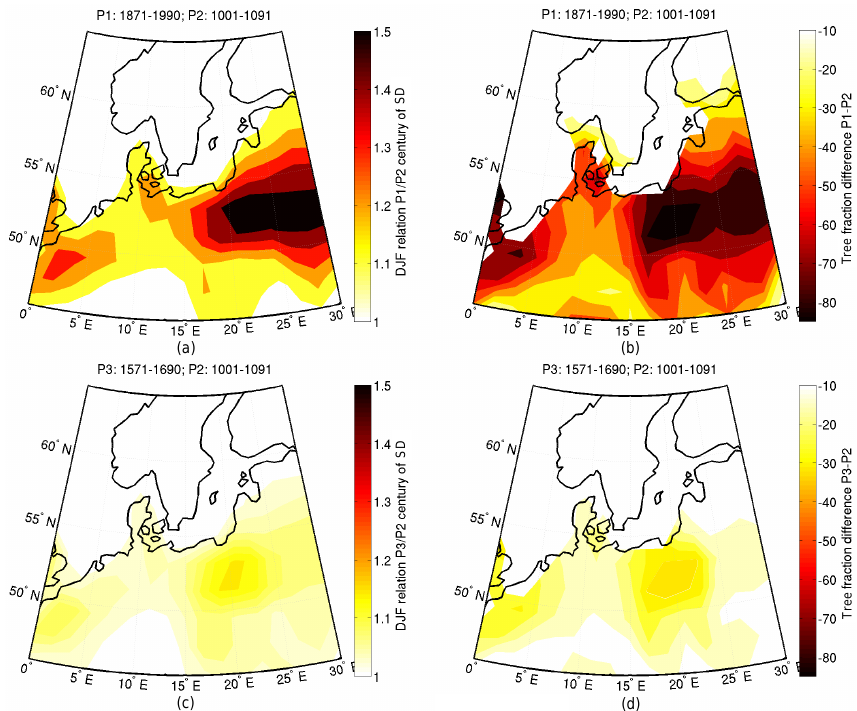
Figure 10. (a) Relation between part 1 (P1: 1871–1990 AD) and part 2 (P2: 1001–1091 AD) standard deviation (SD) of wind speed (ECHAM6). (b) Tree fraction difference of P1 minus P2 derived from Pongratz et al. (2008). (c) Relation between part 3 (P3: 1581–1690 AD) and P2 SD for ECHAM6. (d) Tree fraction difference of P3 minus P2 derived from Pongratz et al.